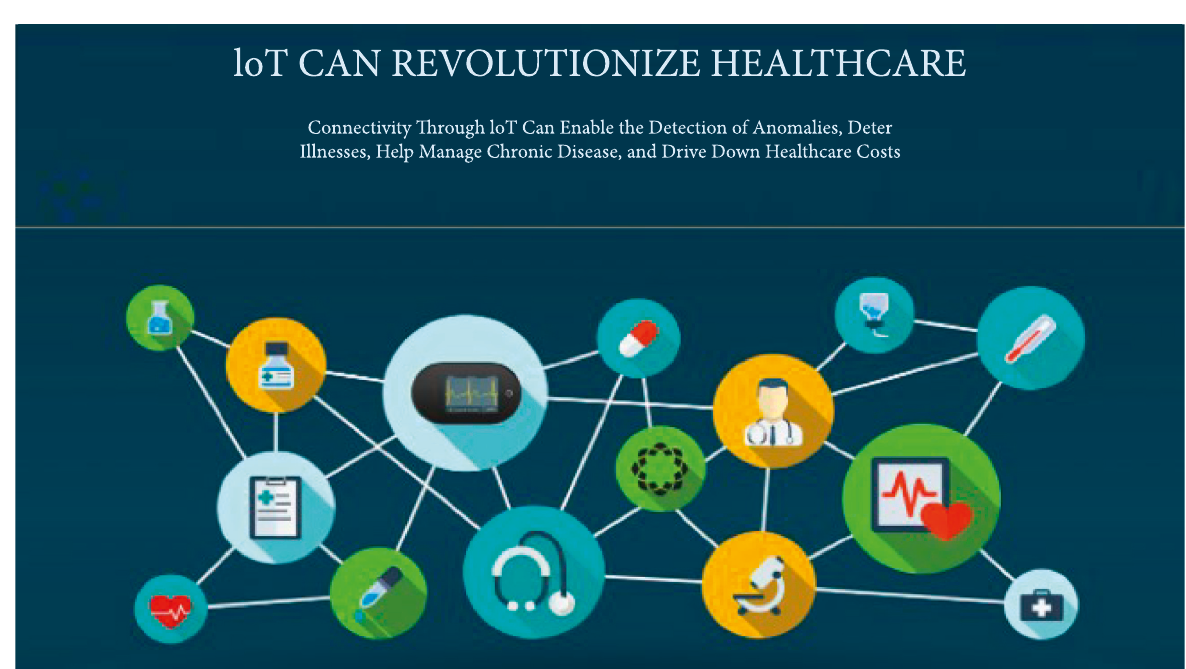
Figure 1: IoT revolution in healthcare